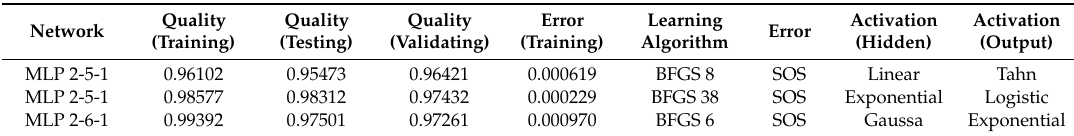
Table 2. Quality of neural networks presented in the